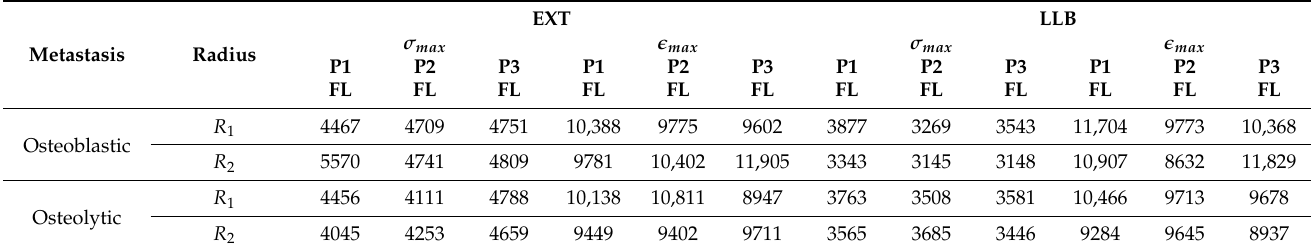
Table 1. The fracture load (FL) expressed in N is reported for each loading condition, failure criterion, type, size, and location of metastasis. EXT (extension) and LLB (left lateral bending) correspond to the loading cases analyzed. The symbols σ max and (cid:101) max refer to maximum principal stress and strain criteria, respectively. P1 (lateral right), P2 (anterior right), and P3 (anterior) correspond to locations of metastases. R 1 and R 2 are the radii of metastasis (5 and 10 mm, respectively).